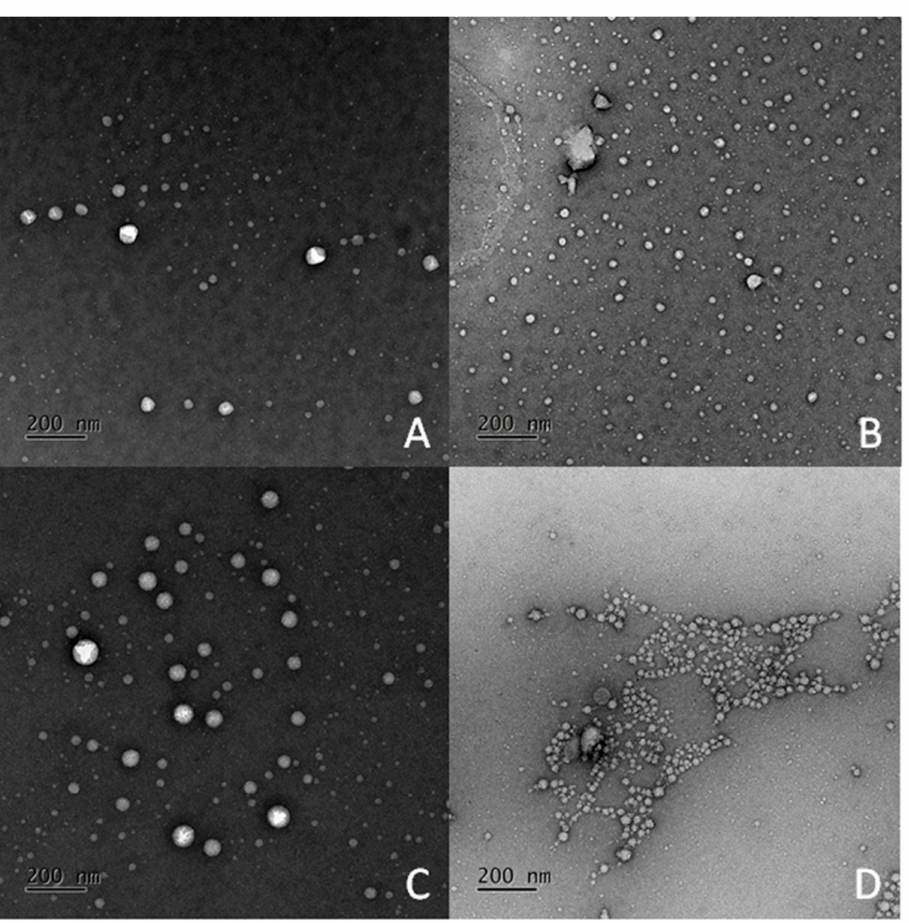
Figure 3. TEM images of extracellular vesicles in patients with ocular diseases. The aqueous humor was harvested from patients with ( A ) cataracts, ( B ) age-related macular degeneration (AMD), ( C ) polypoidal choroidal vasculopathy (PCV), and ( D ) central retinal vein occlusion (CRVO). The images show the representative results of 3 patients per disease. Scale bar indicates 200